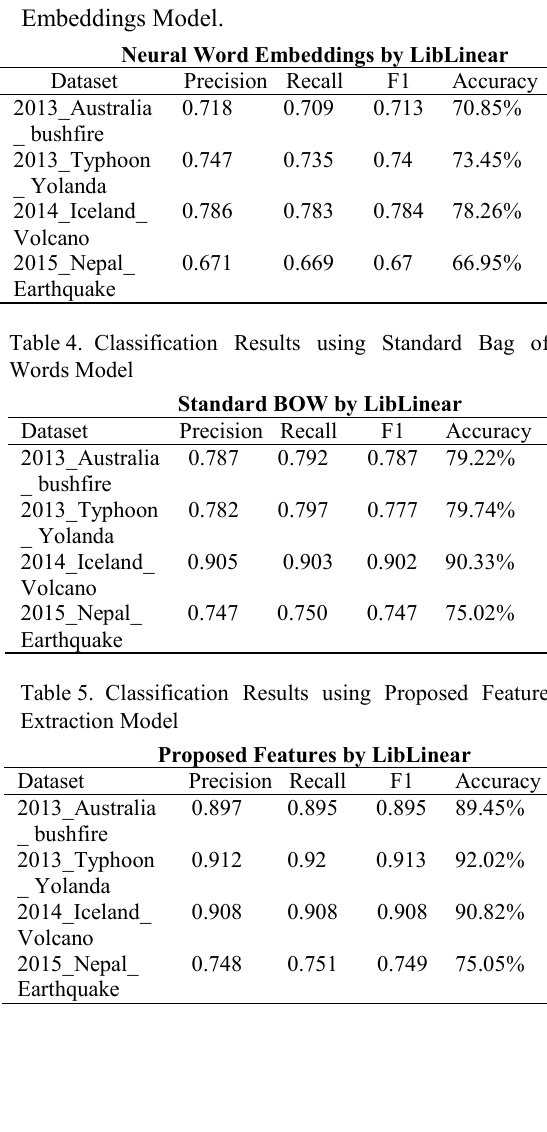
Table 3. Classification Results using Neural Word Embeddings Model.